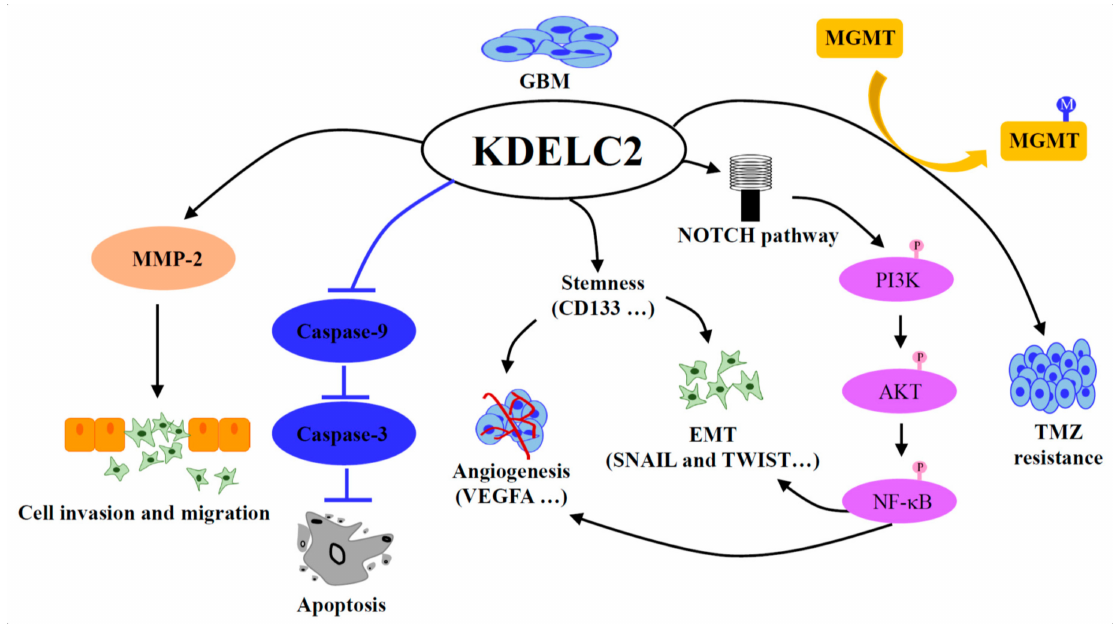
Figure13. TheillustrationshowstheimpactofKDELC2oncancerphenotypeandmolecularmechanism.